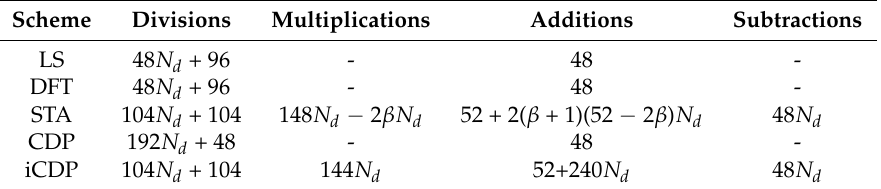
Figure 12. Computation complexity comparison of different schemes. Table 5. Computation complexity comparison of the schemes.